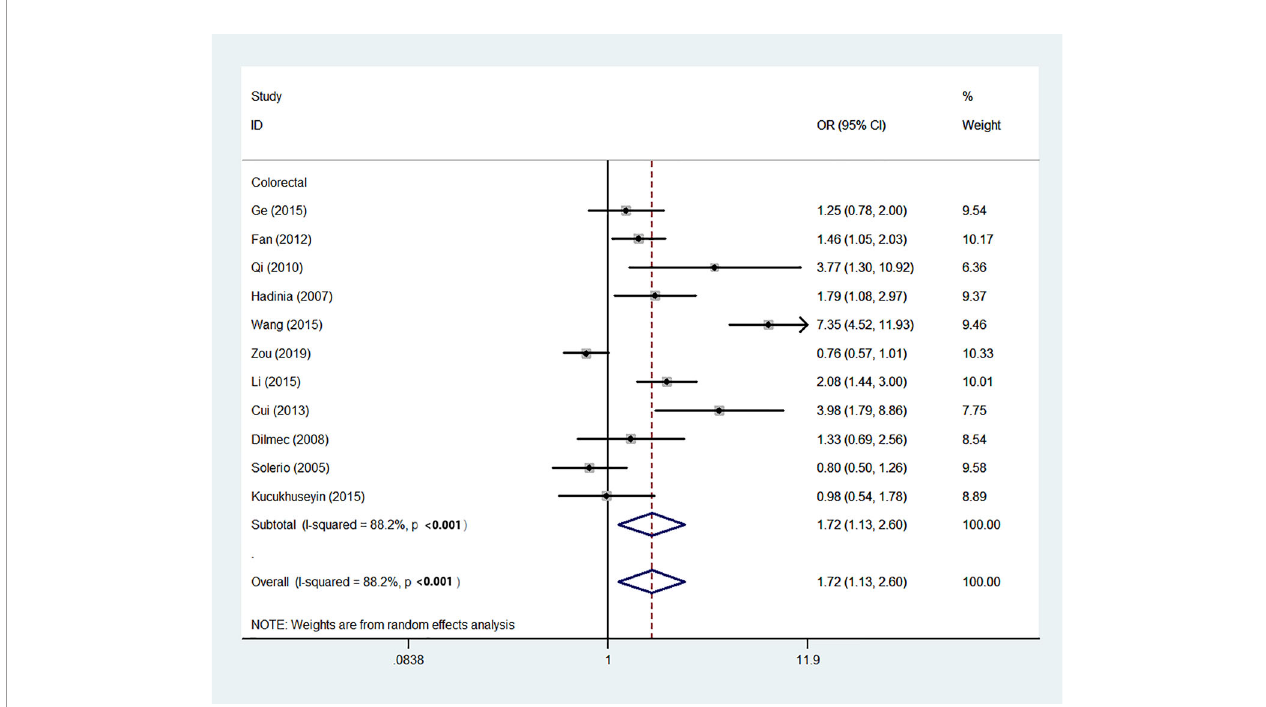
FIGURE 4 | Forest plot of the association between the CTLA-4 gene rs231775 polymorphism and colorectal cancer risk (G-allele vs. A-allele).